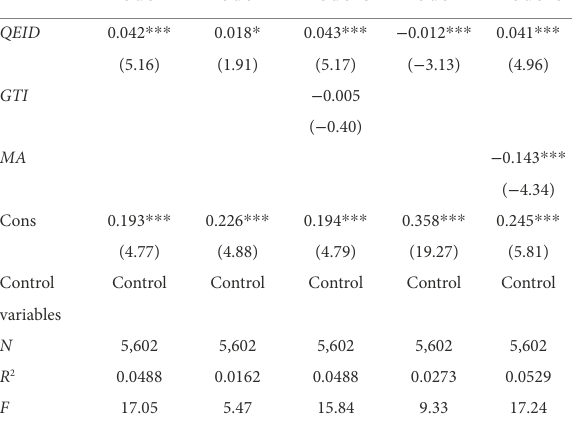
TABLE 12 Results after controlling other variables.